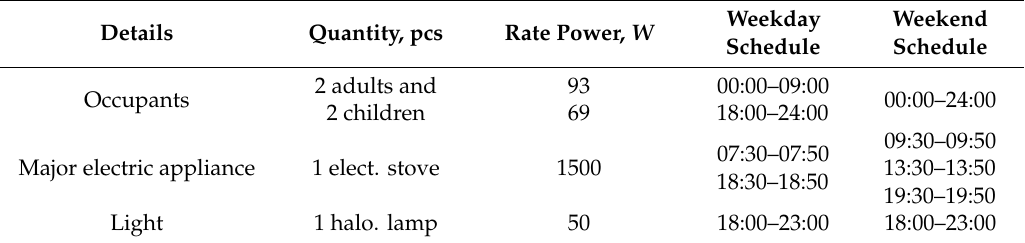
Table 2. Detailed information of the additional heating